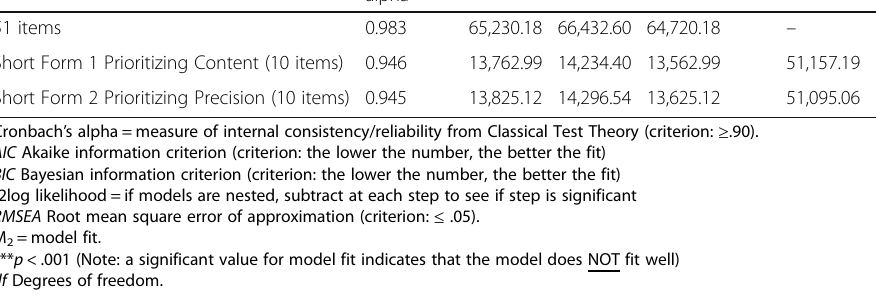
Table 4 Model fit changes for short form selection